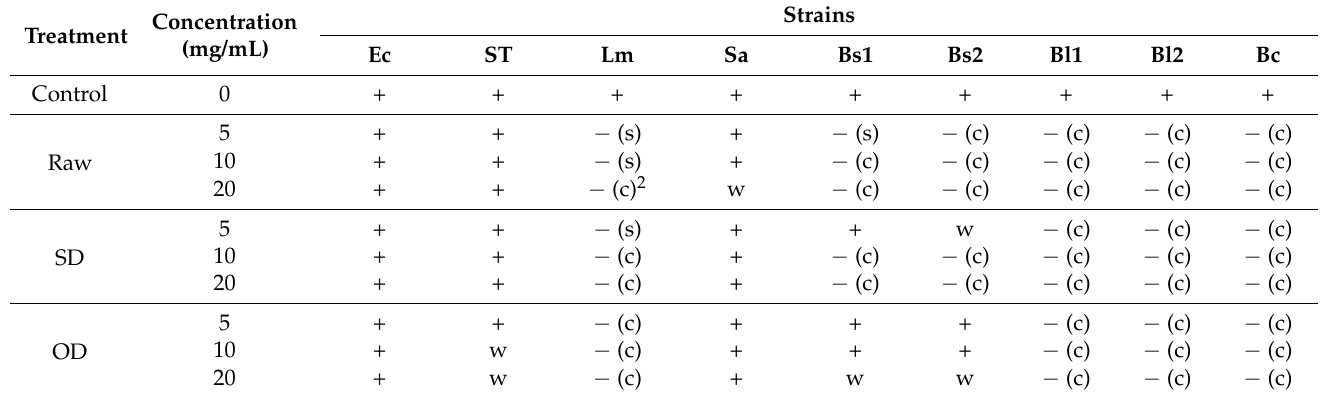
Table 2. Effect of raw dried rosemary (raw) and rosemary residues obtained from distillation followed by sun-drying (SD) or oven-drying (OD) treatment on the growth 1 of E. coli (Ec), S. Typhimurium (ST), L. monocytogenes (Lm), S. aureus (Sa), B. subtilis (Bs1, Bs2), B. licheniformis (Bl1, Bl2), and B. cereus (Bc) strains. When no growth occurred, the mode of action 2 on cell viability was also